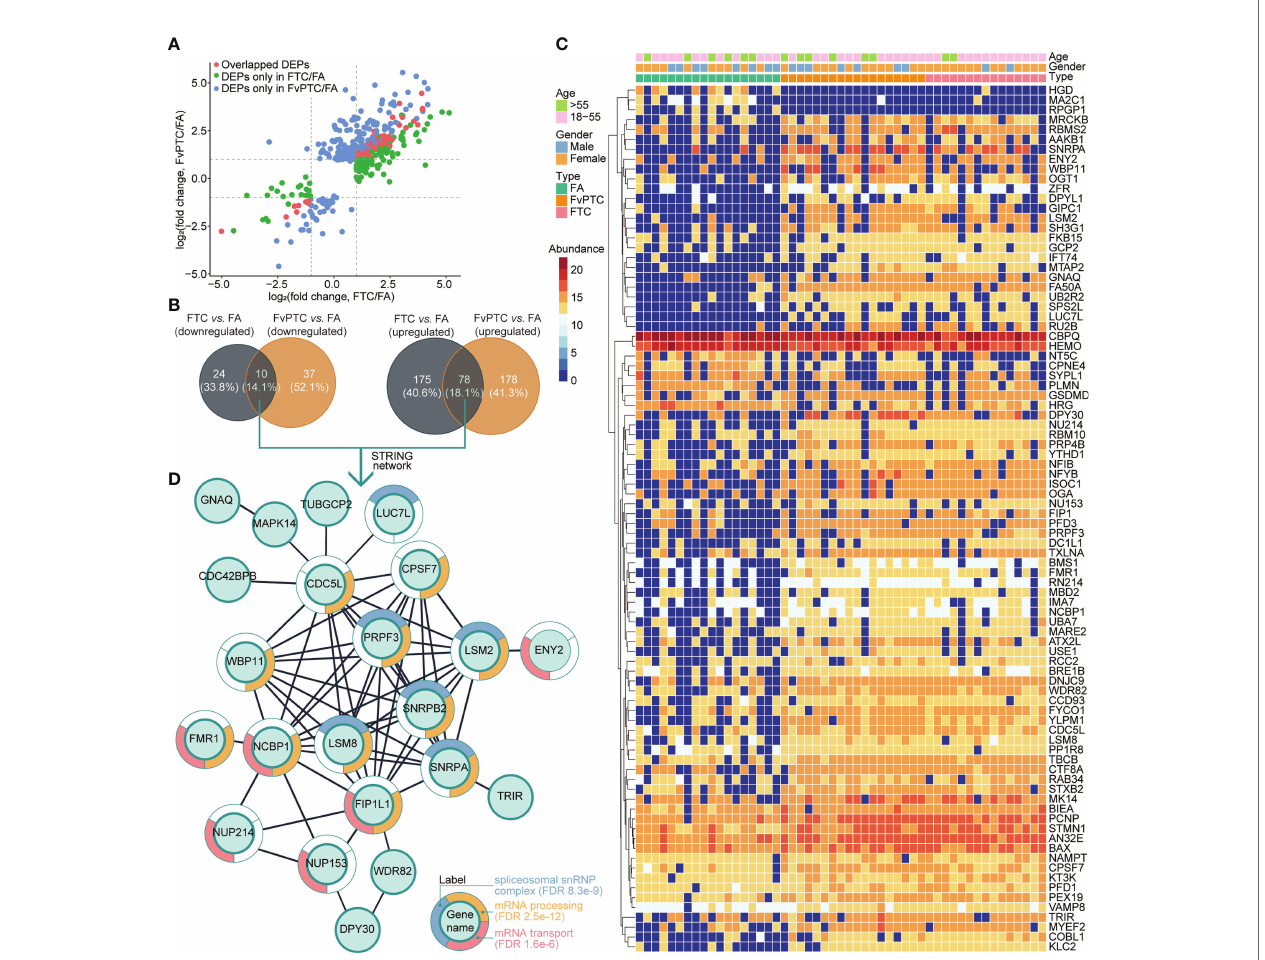
FIGURE 4 | Differentially expressed proteins in malignant tumors vs. the benign tumor and their biological analysis. (A) The differentially regulated proteins in FTC vs. FA and FvPTC vs. FA are distributed in the scatter plots. The overlapped DEPs in the two paired comparisons are colored in red, while the unique DEPs in the FTC vs. FA and FvPTC vs. FA are colored in green and blue, respectively. (B) Venn diagrams showing the total number of DEPs in FvPTC vs. FA and FTC vs. FA. (C) The heatmap exhibited the expression of 88 overlapped dysregulated proteins (panels A, B ). (D) Functional analysis of the largest cluster was obtained by the overlapping upregulated- and downregulated proteins [panels (A, B) ] using the STRING database. The top-three enriched biological process (BP) terms of gene ontology (GO) after redundancy fi ltering are visualized on split donut charts around the nodes annotated with those